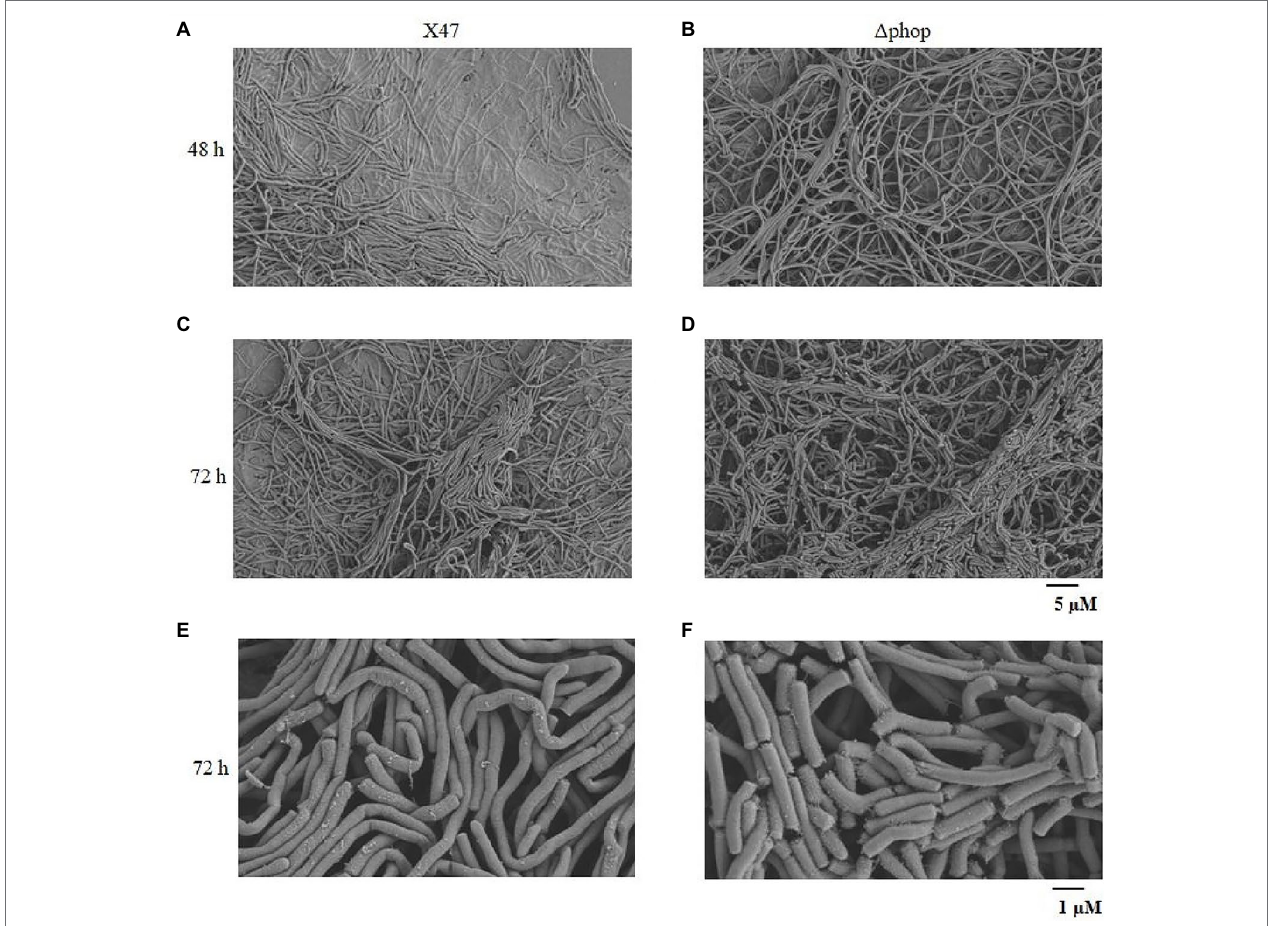
FIGURE 3 | PhoP influences the formation of aerial hyphae and spores in A. pretiosum . (A–D) SEM images of strain X47 after growth on ISP2 medium for 48 h (A) and 72 h (C) , and ∆ phoP strain for 48 h (B) and 72 h (D) . The scale bar is 5 μ M. (E,F) SEM images of X47 (E) and ∆ phoP (F) strains after growth on ISP2 medium for 72 h. The scale bar is 1 μ